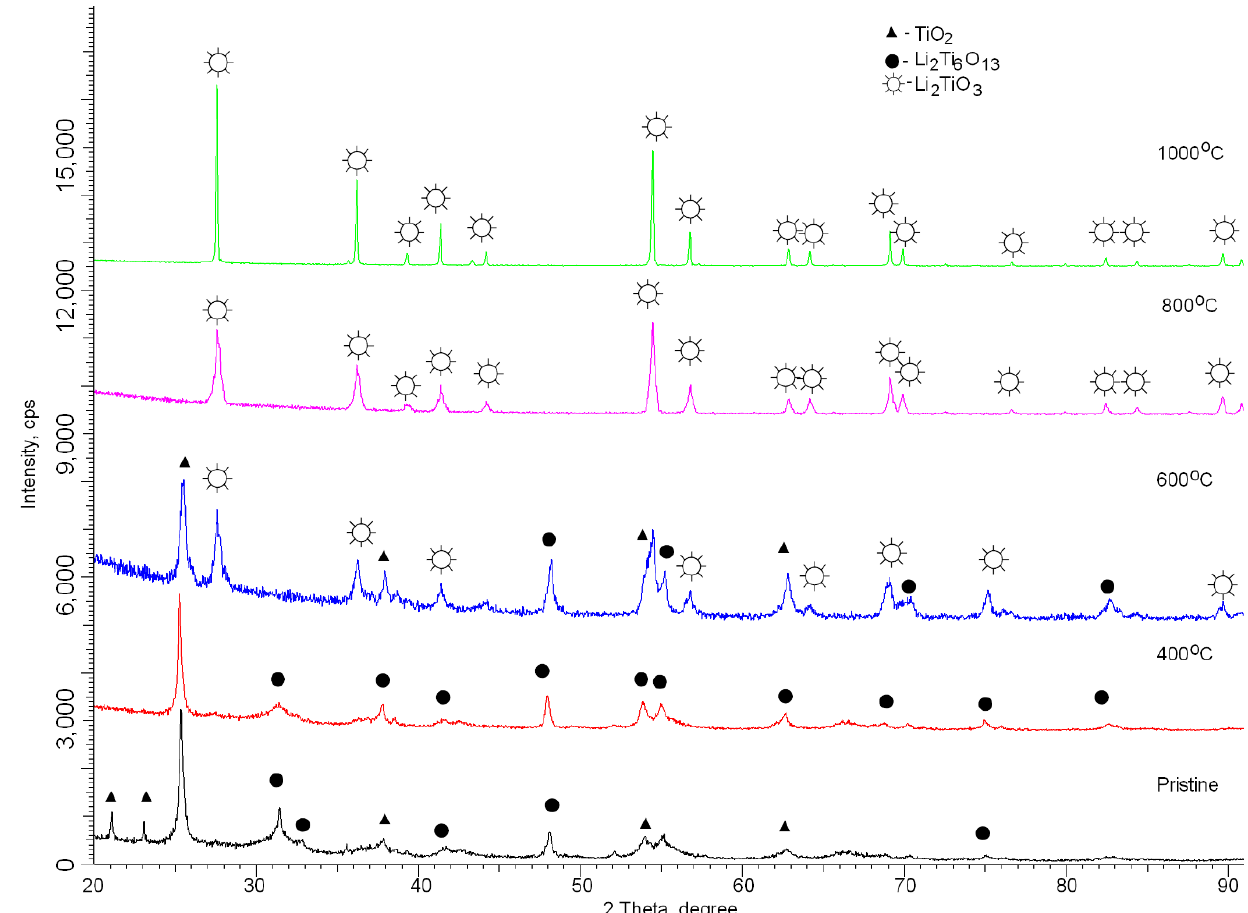
Figure 2. Results of X-ray diffraction of lithium-containing ceramics.